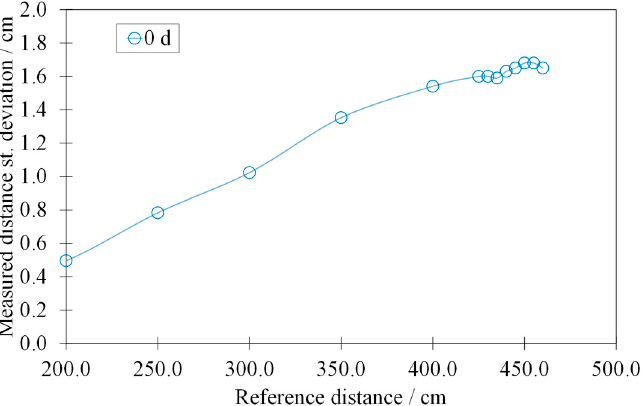
Figure 7. Standard deviation of the calibration curve of the HY-SRF05 without outliers and invalid measurements.